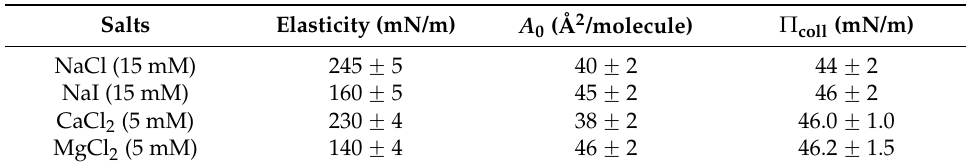
Table 1. Gibbs elasticity values at the maximum, lift-off molecular area A 0 and collapse pressure Π coll for CHOL monolayer at different